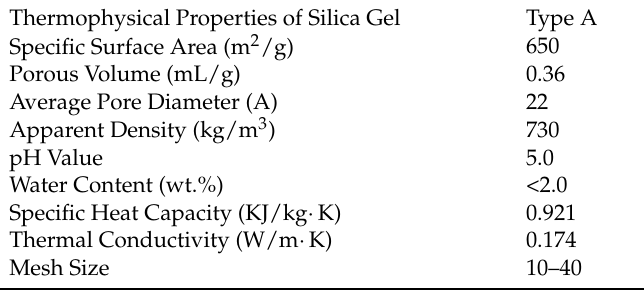
Table 9. Thermo-physical properties of alumina fins.